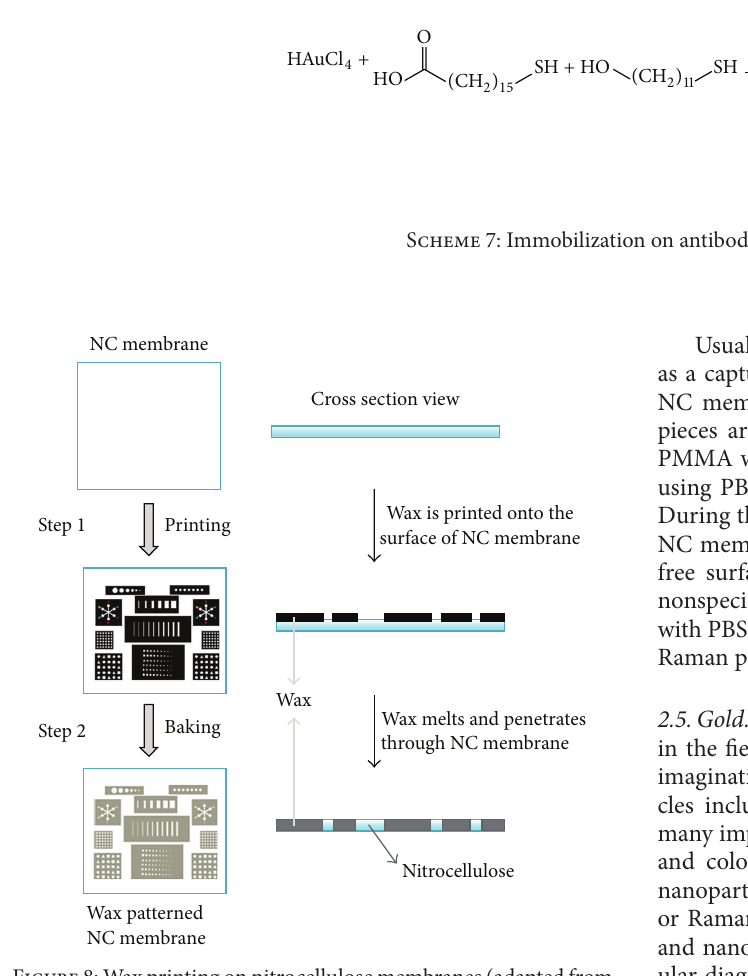
Figure 8: Wax printing on nitrocellulose membranes (adapted from